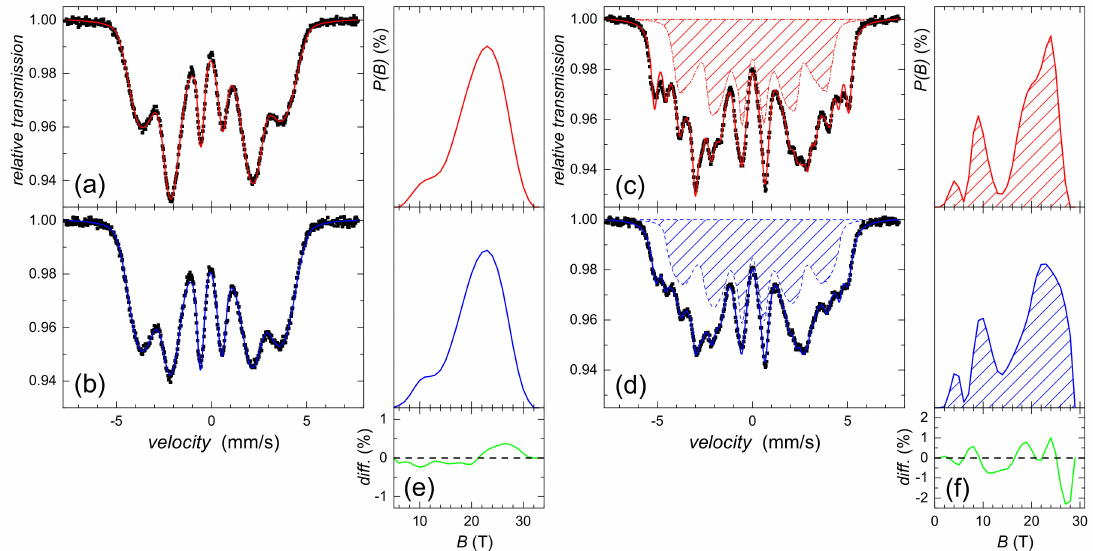
Figure 9. Mössbauer spectra of the Fe 73.5 Nb 3 Cu 1 Si 13.5 B 9 amorphous metallic alloy with corresponding distributions of hyperfine magnetic fields, P ( B ): ( a ) Non-irradiated amorphous sample; ( b ) amorphous sample after neutron irradiation; ( c ) non-irradiated nanocrystalline sample; ( d ) nanocrystalline sample after neutron irradiation; ( e ) differences between P ( B ) distributions of amorphous samples; ( f ) differences between P ( B ) distributions of nanocrystalline samples. Spectral components representing the amorphous residual phase in nanocrystalline samples are plotted in ( c , d